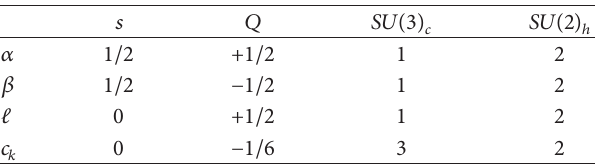
Table 1: Quantum numbers of the six haplons: spin ( 𝑠 ), electric charge 𝑄 (in units of |𝑒| ), and corresponding representations of 𝑆𝑈(2) 𝑆𝑈(3) 𝑐 and ℎ .